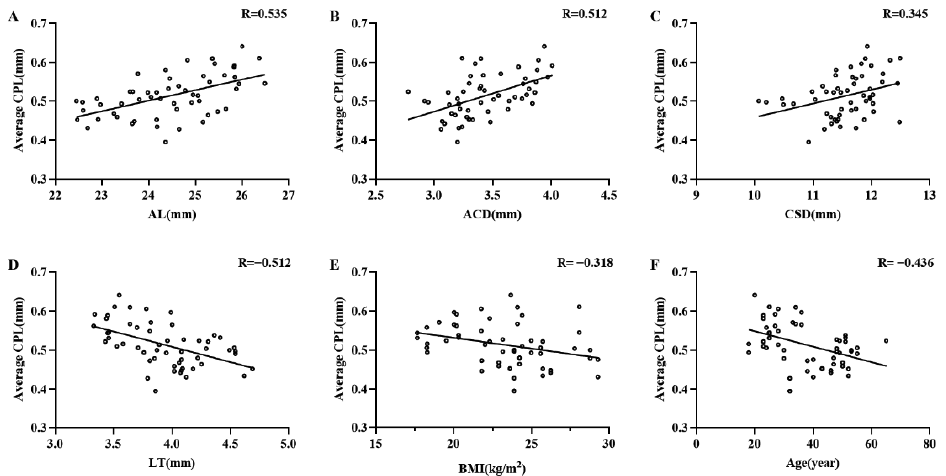
Figure 4. Scatter plots of AL ( A ), ACD ( B ), CSD ( C ), LT ( D ), BMI ( E ), age ( F ), and average CPL in all recruited eyes. The longer the AL, the deeper the ACD, and the larger CSD were, the longer the CPL was. The smaller the BMI and the thinner the LT were, the longer the CPL was. The younger the subject was, the longer the CPL was. The solid line represents the best-fit line.